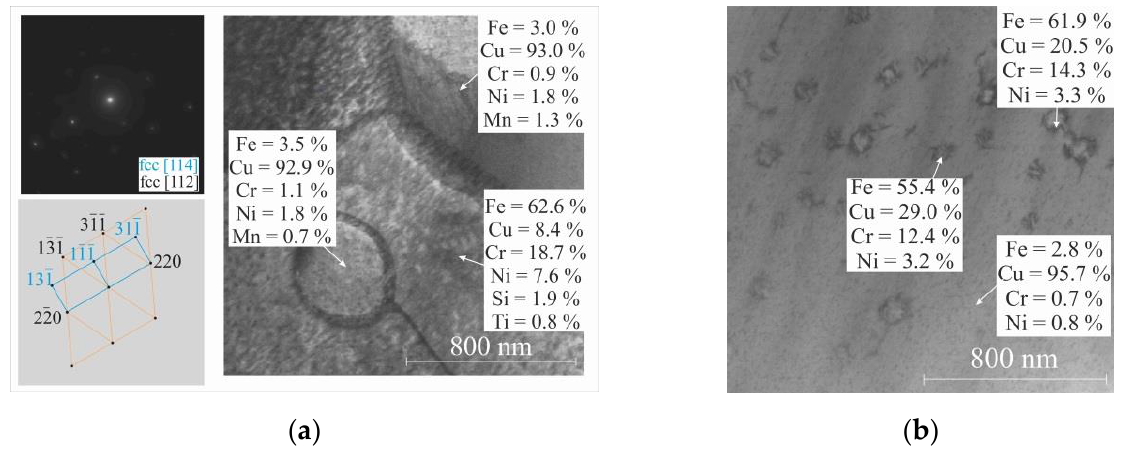
Figure 14. TEM image of bimetal laminate macrocomposite boundary: ( a ) “SS–Cu” shows hardening of steel with copper; ( b ) “Cu–SS” shows spinodal decomposition. The elemental compositions of the Cu-based and Fe-based samples in wt. % as revealed by TEM EDS analysis.